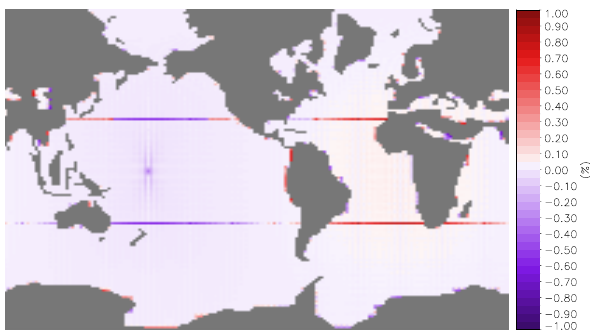
Fig. 5. Relative error obtained (in %) with the bilinear regridding from the LMDz grid to the ORCA2 grid.